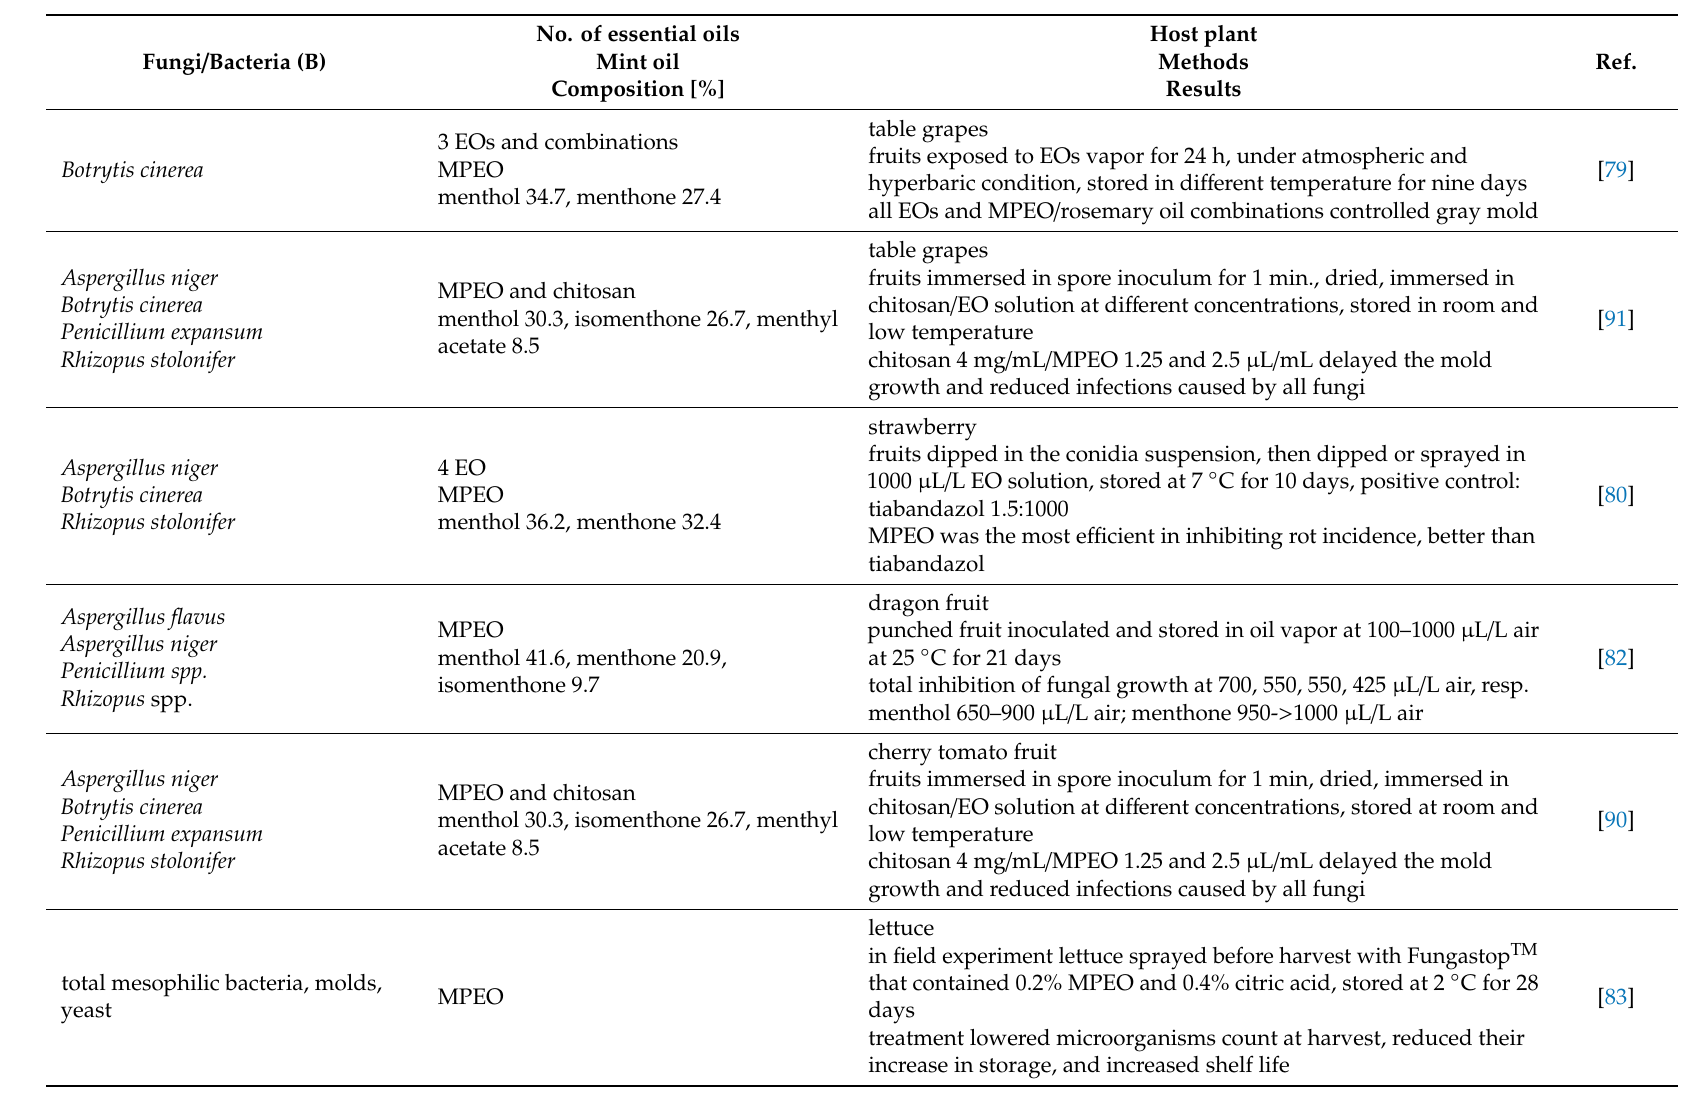
fruits exposed to EOs vapor for 24 h, under atmospheric and hyperbaric condition, stored in di ff erent temperature for nine days all EOs and MPEO / rosemary oil combinations controlled gray mold fruits immersed in spore inoculum for 1 min., dried, immersed in chitosan / EO solution at di ff erent concentrations, stored in room